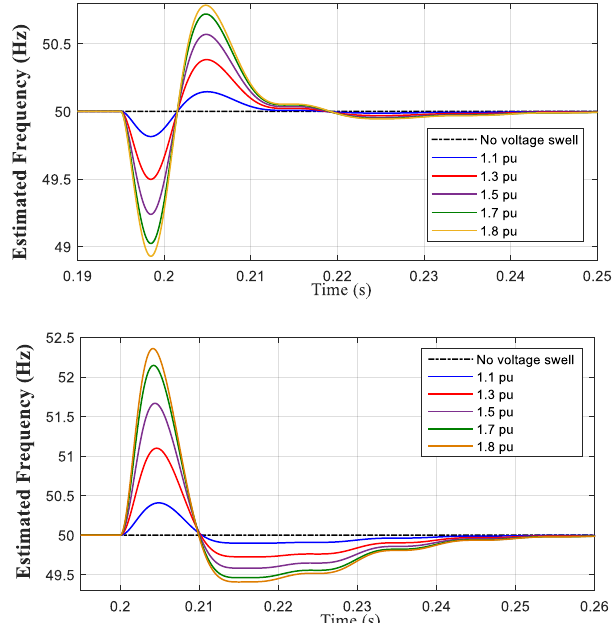
Figure 16. Perturbations induced in the SOGI-FLL estimated frequency for di ff erent voltage swell levels. Upper: at non-zero input voltage. Lower: at zero crossing input voltage.